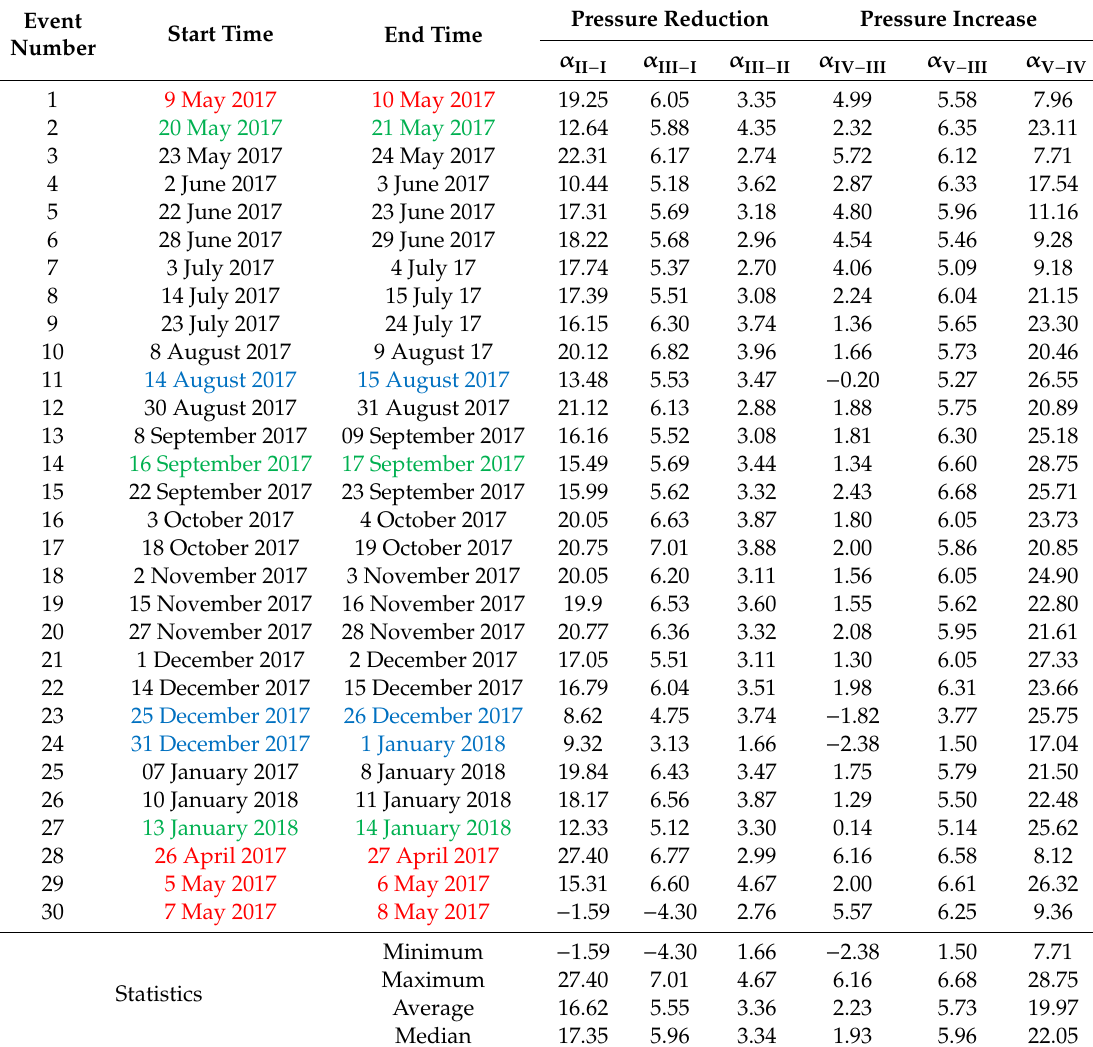
Table 2. Values and statistics of the rate α k − n for selected measurement events during the reduction and increase of pressure (blue: holidays, red: pre-failure, after and failure days, green: weekends, black: working